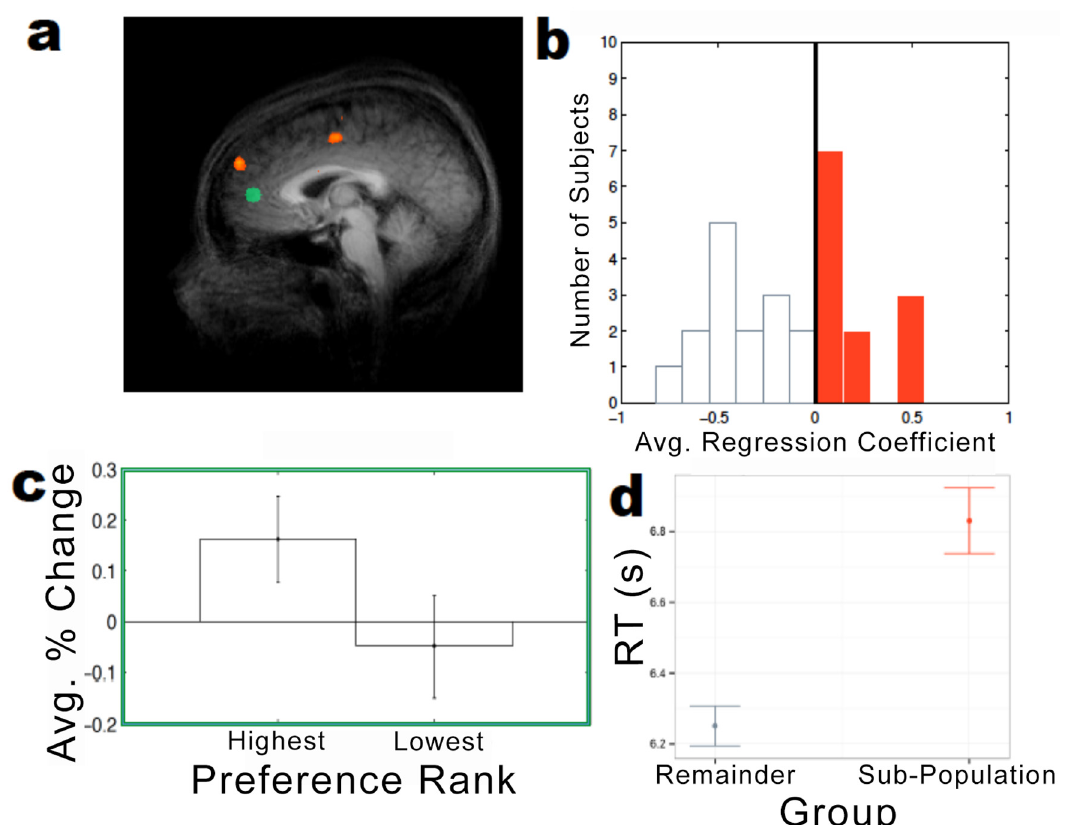
Fig 9. (a) Regions correlated with environmental preferences (p < 0.05, uncorrected) for exploratory sub-population (orange) relative to a priori vmPFC region of interest (green). (b) Selection of exploratory sub-population based on average whole-brain regression coefficient for environmental proposals. (c) Differential activity within exploratory sub-population ’ s vmPFC region for favored vs. nonfavored proposals. (d) Reaction time differences between exploratory sub-population and remaining